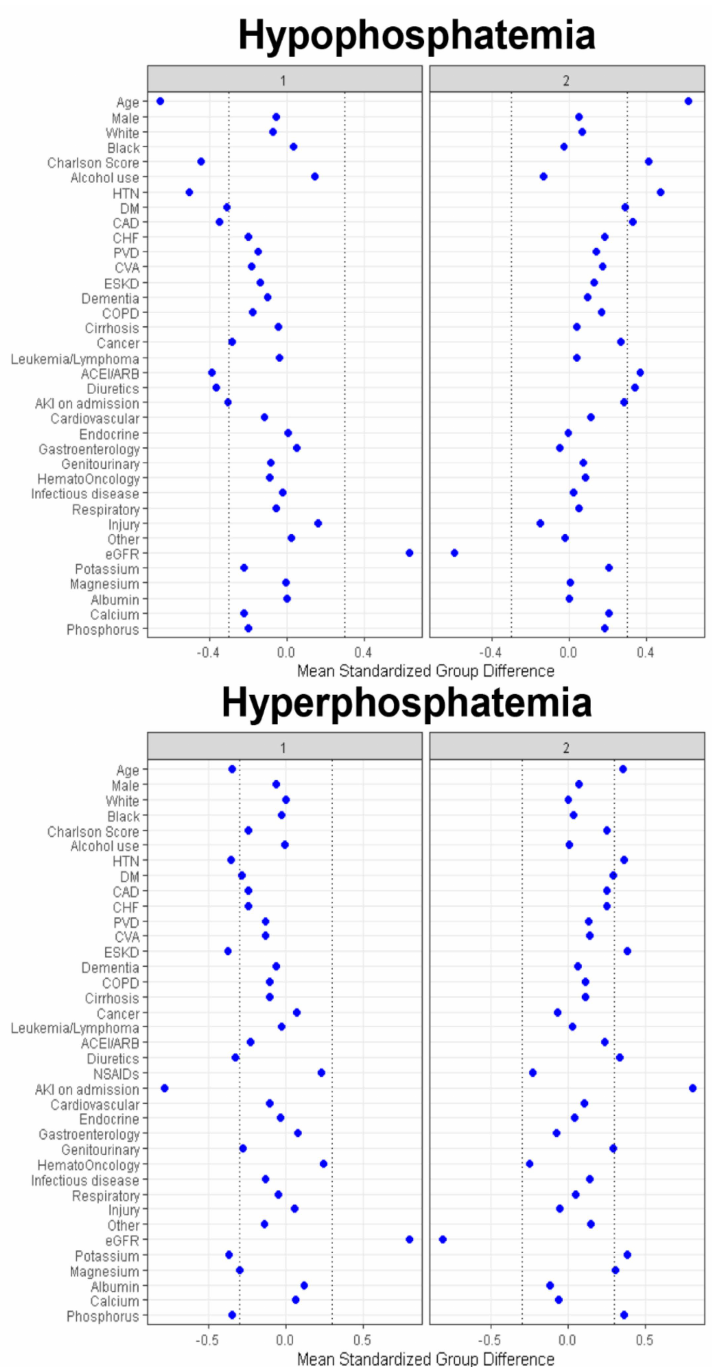
Figure 3. Standardized mean differences across the two clusters for each baseline variable for patients with hypophosphatemia and hyperphosphatemia. The x axis represents the standardized differences value, and the y axis represents baseline variables. The dashed vertical lines signify the standardized differences values of < − 0.3 or >0.3. Abbreviations: AG, anion gap; AKI, acute kidney injury; BMI, body mass index; CHF, congestive heart failure; Cl, chloride; COPD, chronic obstructive pulmonary disease; CVA, cerebrovascular accident; DM, diabetes mellitus; ESKD, end stage kidney disease; GFR, glomerular filtration rate; GI, gastrointestinal; Hb, hemoglobin; HCO3, bicarbonate; K, potassium; ID, infectious disease; MI, myocardial infarction; Na, sodium; PVD, peripheral vascular disease; RS, respiratory system; SID, strong ion